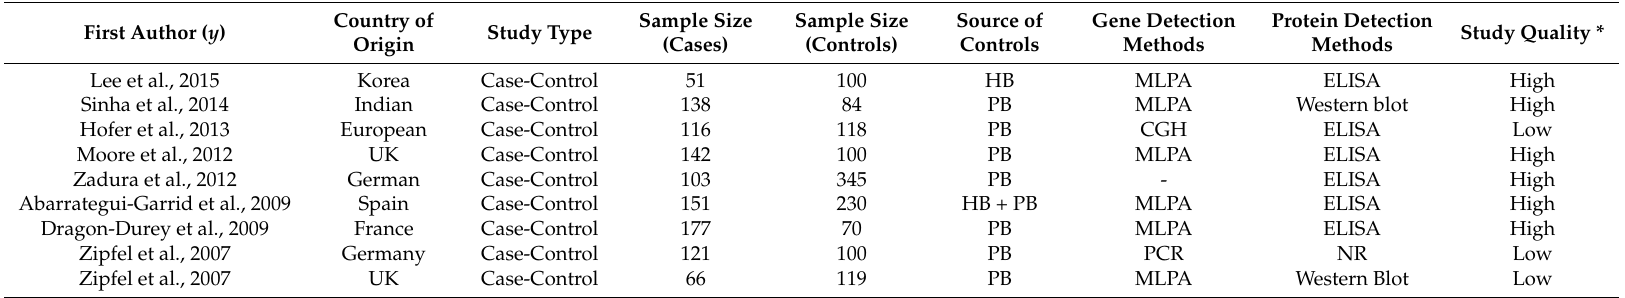
Table 1. Characteristics of studies included in this